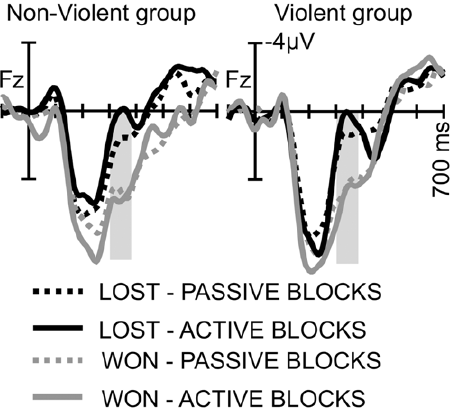
Figure 5. ERPs in the flanker task. ERPs are locked to the response; correct responses are shown in gray scale, erroneous responses are shown in black. Groups are indicated by line style.